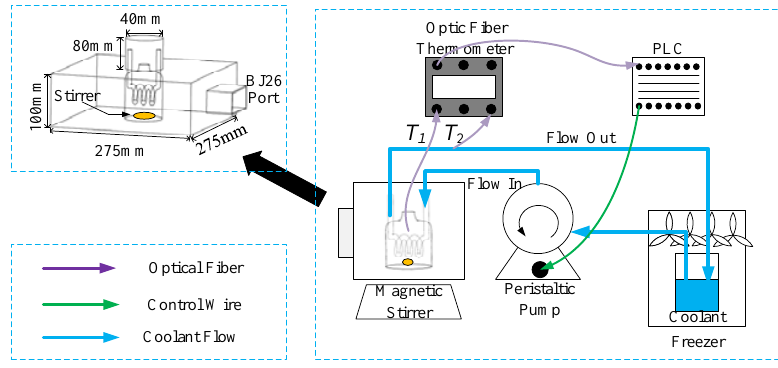
Figure 3. The local detail of the experimental setup.